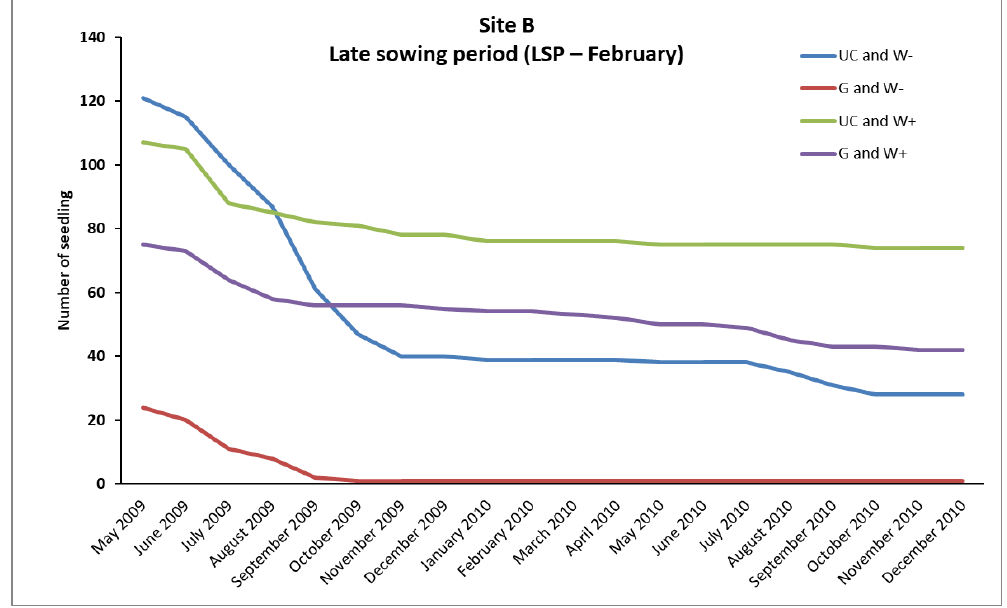
Figure 3. Monthly seedling survival (number of living seedlings) of the February sowing (LSP) in the plots of each combination of the two factor levels in site B for the period May 2009–December 2010 (the May 2009 record shows the number of germinated seeds).